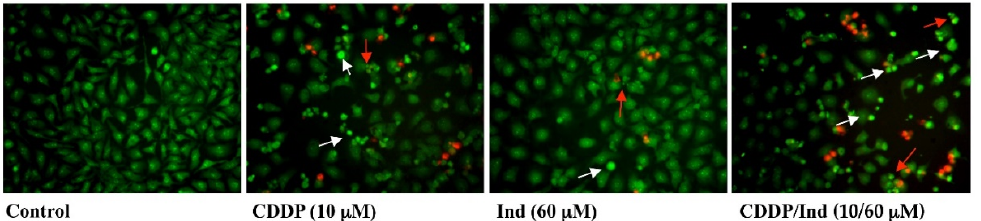
Figure 4. Cell apoptosis assessed by AO/EB double staining. Fluorescence micrographs representative of three separate experiments with similar results. White arrow: cells with chromatin condensation; red arrow: cells with membrane blebbing.